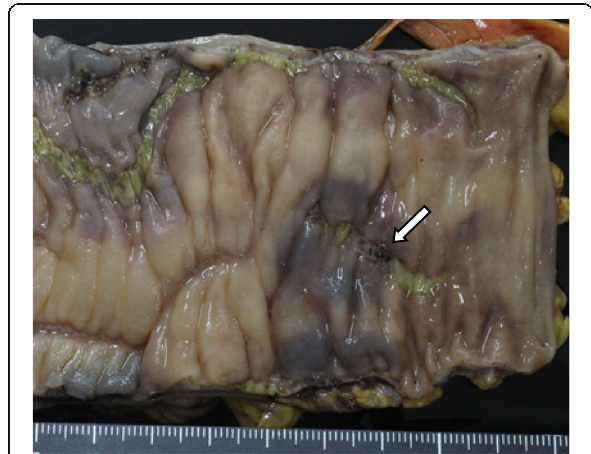
Fig. 2 Macroscopy of the resected colon: cross sections of the bowel show normal-appearing mucosa, markedly thickened edematous wall, and longitudinal ulcer. The arrow indicates the perforation